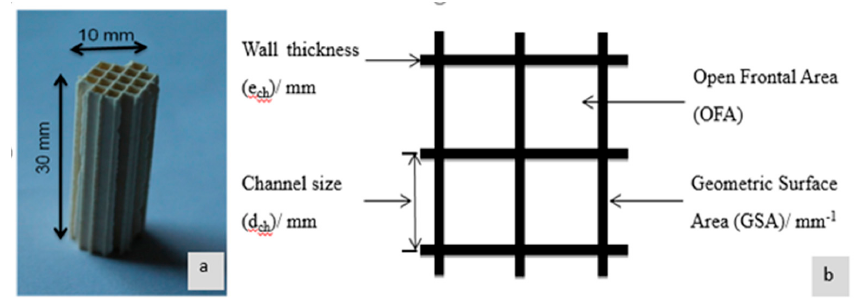
Figure 4. ( a ) Photography of a monolith used in this study and ( b ) schematic representation of the main geometrical parameters of the ceramic monoliths. Table 3. Geometrical parameters of the used ceramic monoliths.